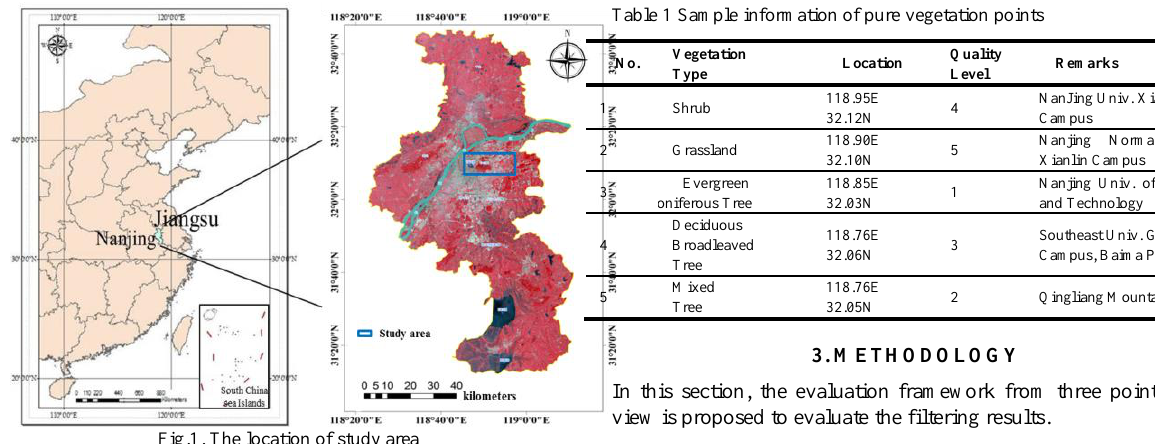
Fig.1. The location of study area